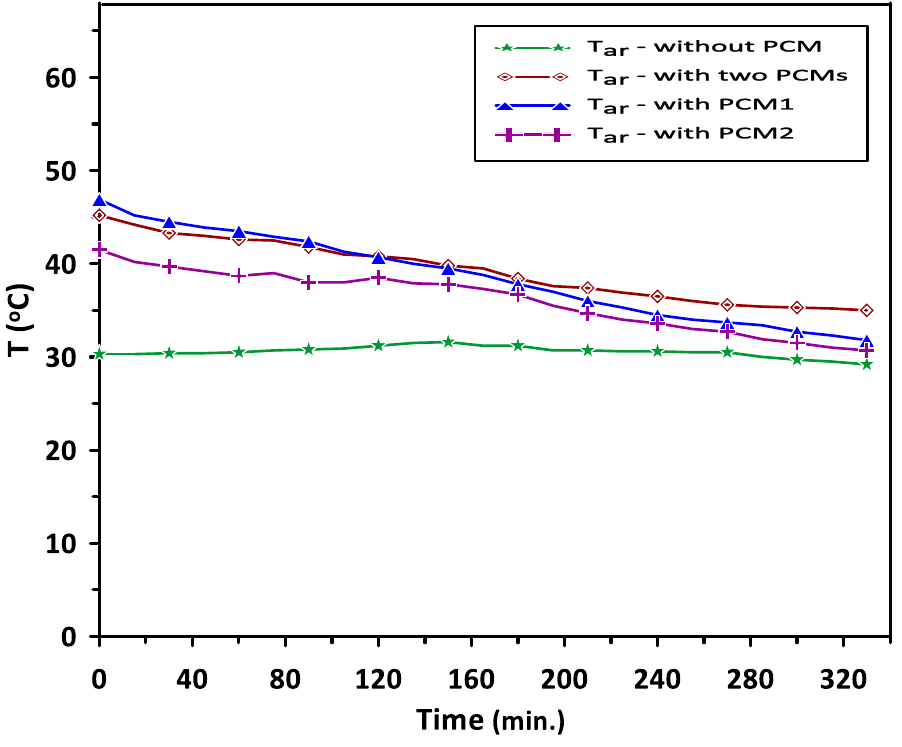
Figure 9. Air temperature variation in the room model with and without using PCMs during the discharging cycle. discharging